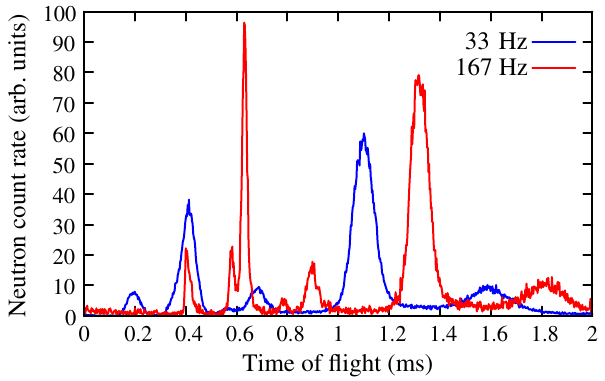
FIG. 5. TOF spectra obtained with two rotation speeds ¼ 33 Hz and f ¼ 167 Hz). The times shown are as ( f rot rot measured, that is, t has not been corrected offset